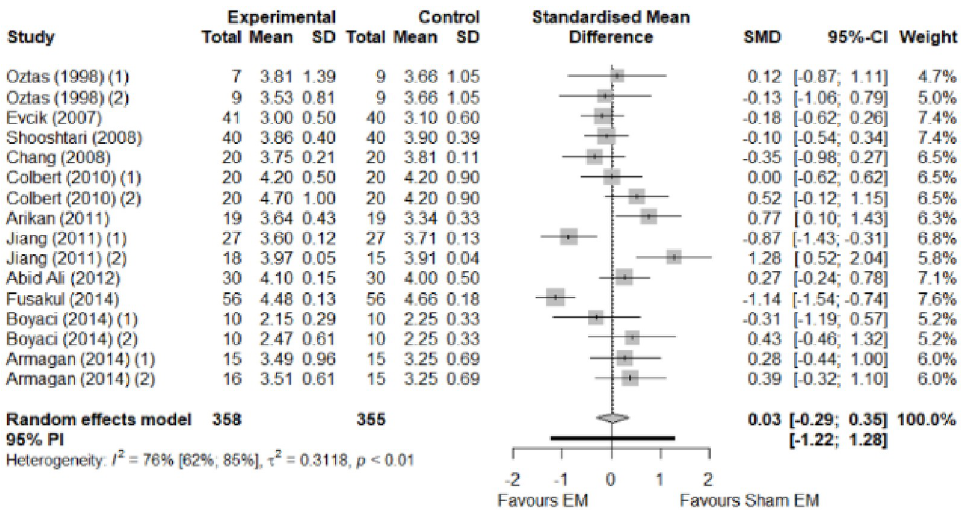
Fig 5. Analysis—Electrophysical modalities versus placebo (sensory latency). Studies with more than two intervention groups (different modalities, treatment doses, or symptom classification) were numbered as (1) and